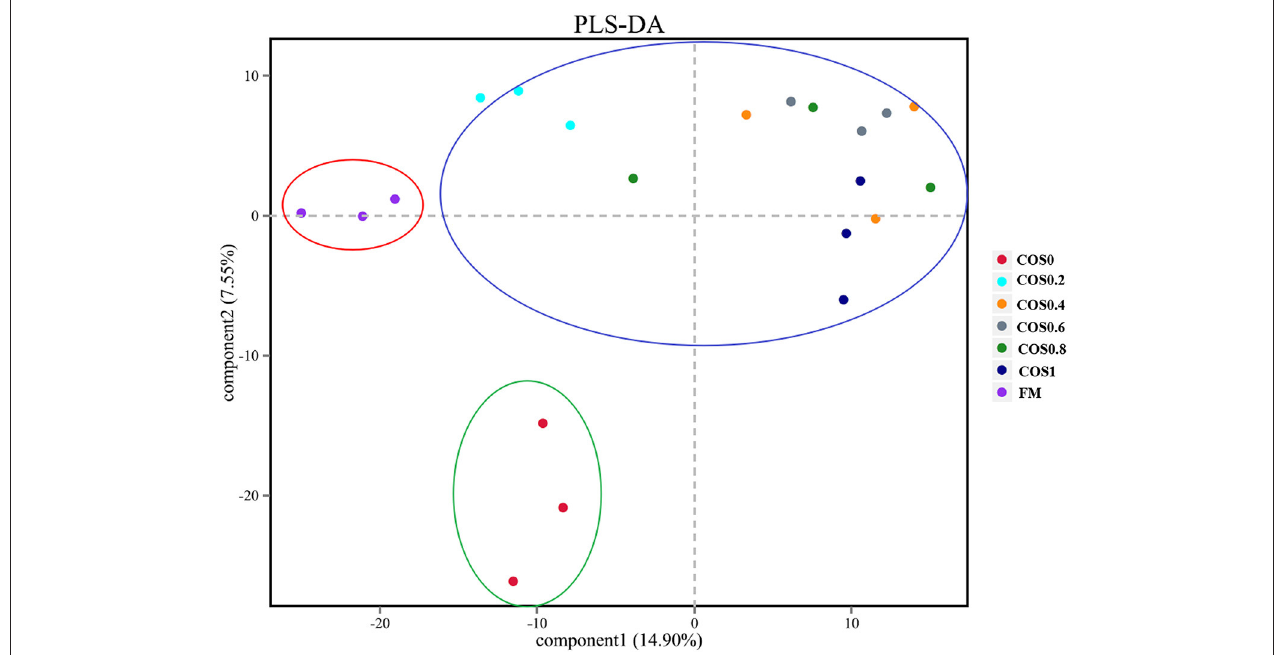
FIGURE 6 | Comparison of overall bacterial composition between treatments by partial least squares discrimination analysis (PLS-DA) in grouper intestinal